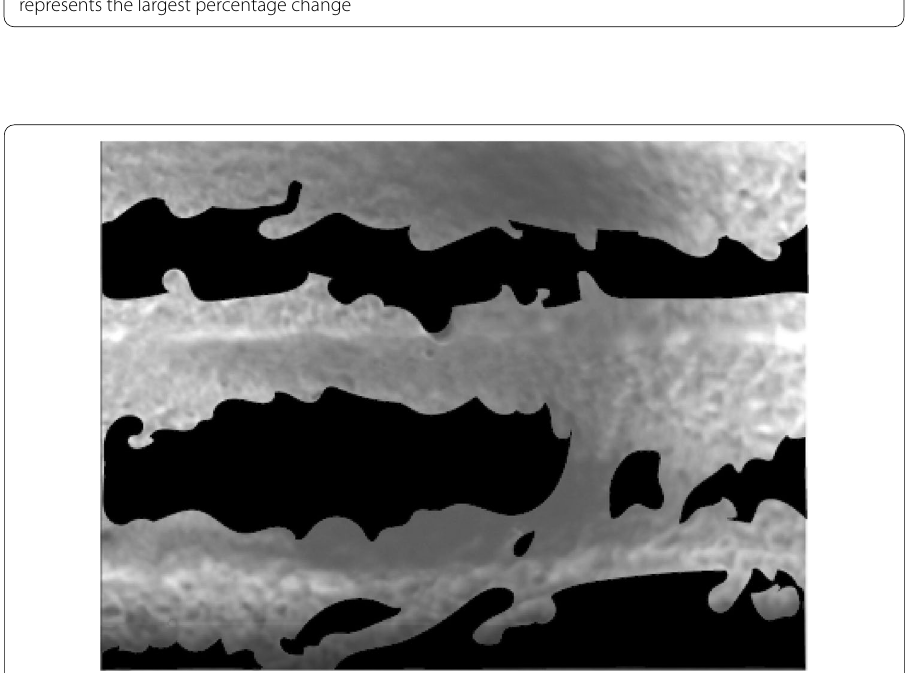
Fig. 7 Representative image showing regions (white) where cilia activity continued (63% of the area) after mucociliary transport had ceased shown in Additional file 1: Video